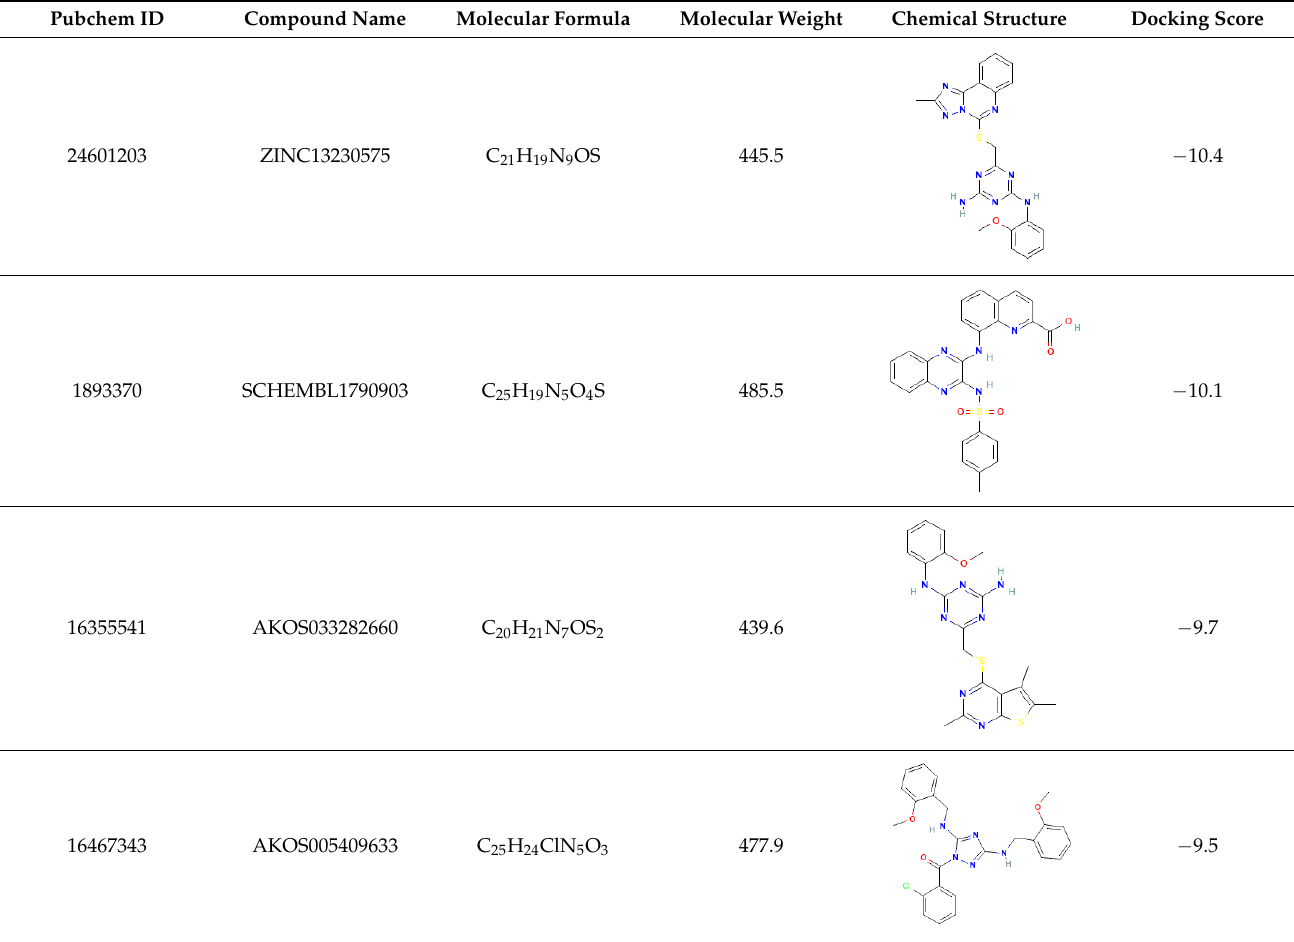
Table 2. Docking score with FAK1 protein, docking score and molecular weight of the top four selected compounds.